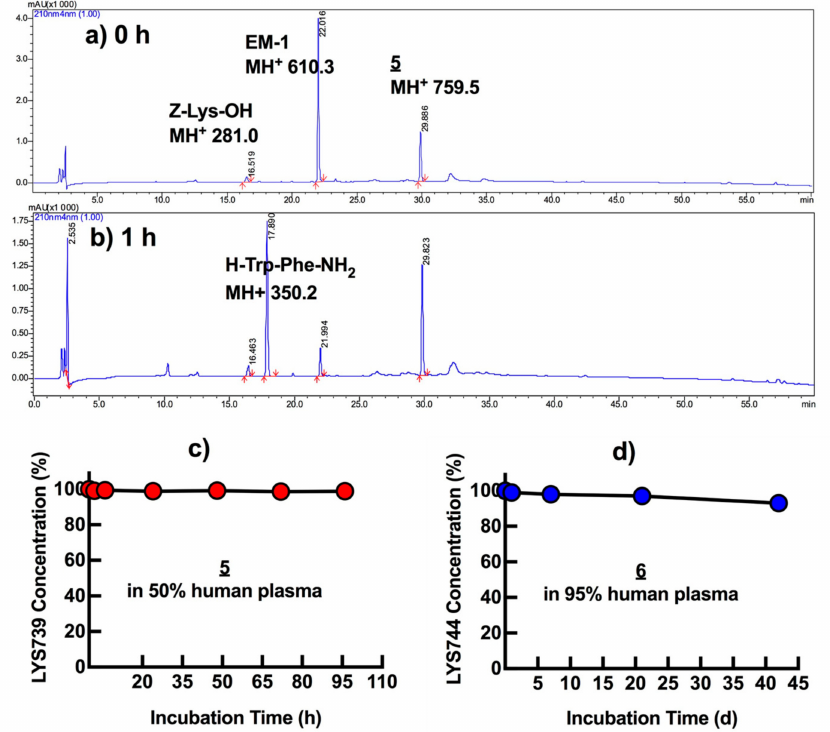
Figure 6. Stabilities of 5 and 6 in human plasma at 37 ◦ C. ( a ) HPLC profile of 5 , EM-1, and Z-Lys-OH (internal standard); ( b ) after 1 h incubation at 37 ◦ C. Gradient: 3–75% of B solution (0.05% HCOOH in acetonitrile) in A solution (0.05% HCOOH in water) within 48 min; ( c ) overall long-term stabilities of 5 in 50% human plasma; and ( d ) 6 in 95% human